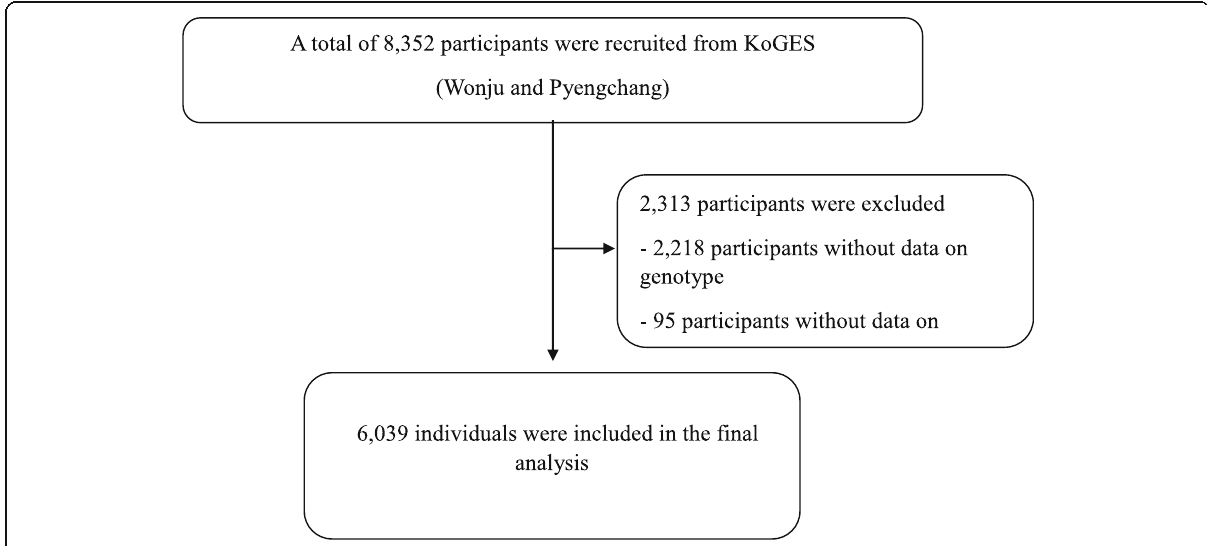
Fig. 1 Flowchart showing the final selection in cohort A. KOGES, The Korean Genome and Epidemiology